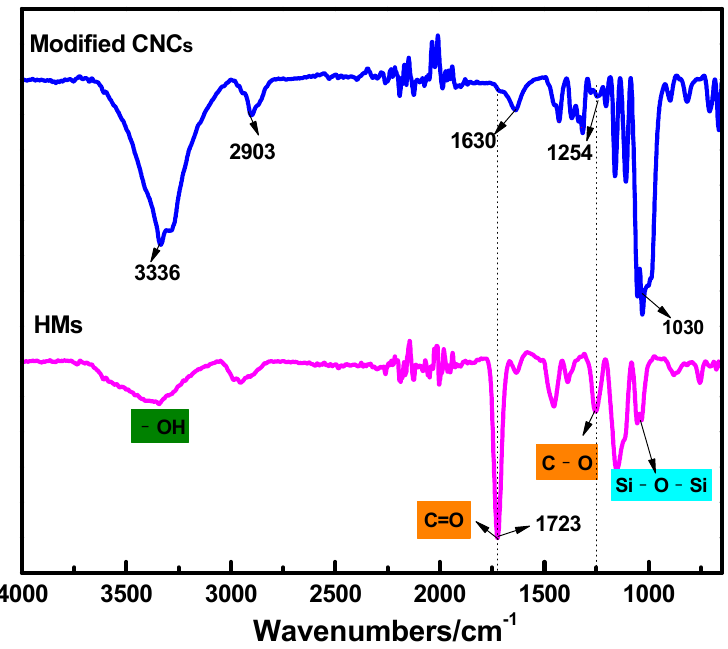
Figure 3. FT-IR spectra of ( a ) modified CNCs and ( b ) HMs.